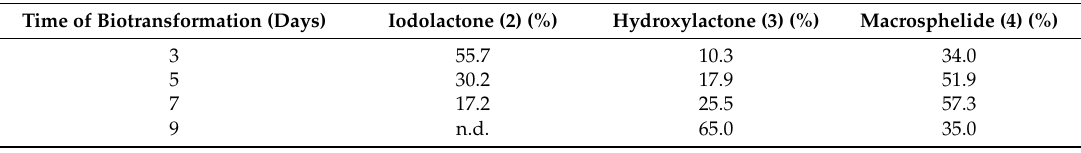
Table 2. The results obtained with iodolactone 2 in the log growth phase (according to GC-FID).